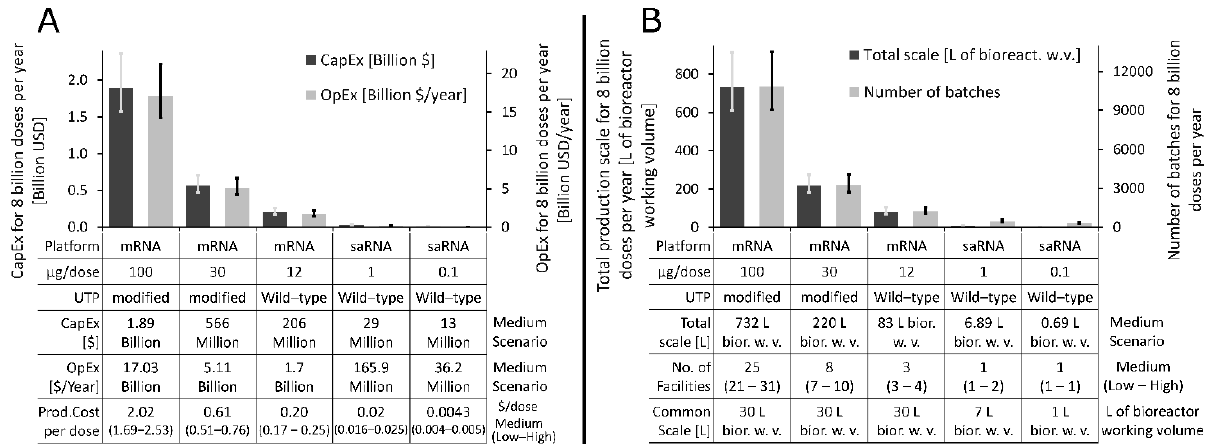
Figure 3. Resource and production scale requirements for producing 8 billion doses of LNP formulated RNA drug substance per year. Variations in production efficiencies were modelled by changing the production titre by −20% for the low scenario, leaving it at the 5/L baseline value for the medium scenario and increasing it by +20% for the high scenario. The bar charts represent the results for medium scenario and the error bars show the results for the low and high scenarios. ( A ) Total capital investment cost (CapEx) and annual operating cost (OpEx) required to produce 8 billion doses of RNA DS per annum for the five RNA vaccine types. The five vaccine types, their characteristics and cost-modelling results are shown in the table belonging to the x-axis. ( B ). Total production scales expressed in L of bioreactor working volume and the number of batches required to meet the RNA DS annual demand of 8 billion doses for the five RNA vaccine types. The five vaccine types and their common techno-economically feasible scales are shown in the table belonging to the x-axis. Additionally, this table also shows the total production scales required for meeting the 8 billion dose of DS annual demand and the number of facilities required to meet the same demand, assuming one production line at the techno-economically feasible scale per facility.